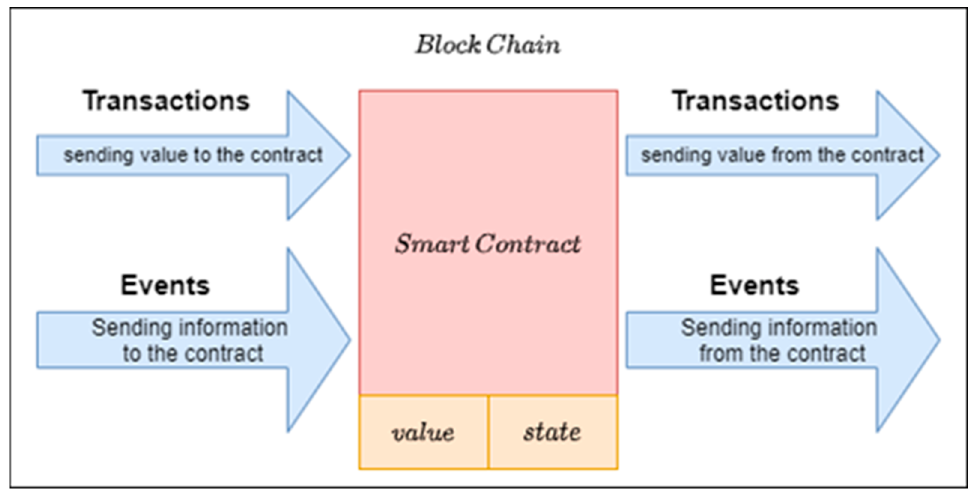
Figure 1. Smart contract structure.